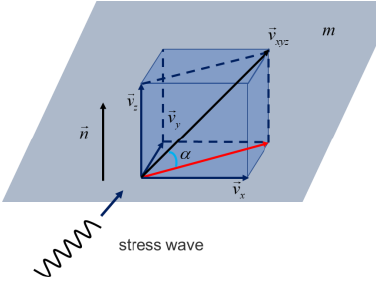
Figure 9. Particle velocity vector.